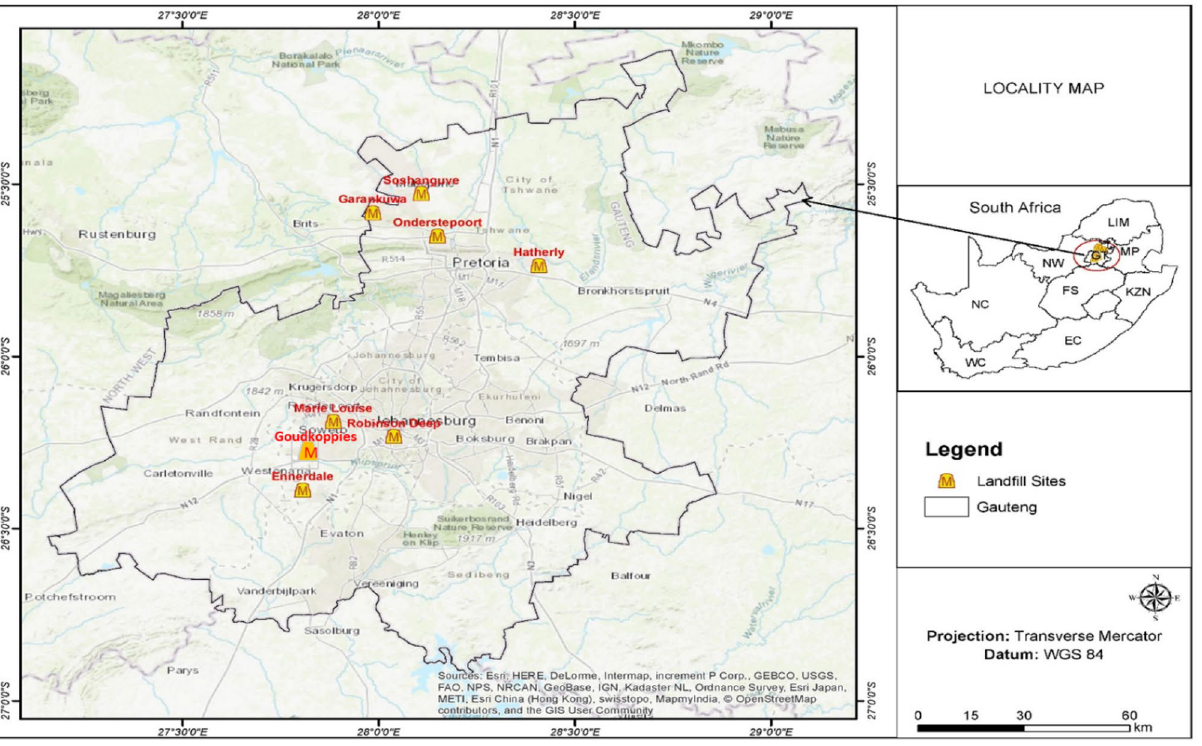
Figure 1. Map of South Africa (top right) and Gauteng Province (centre) showing the selected landfill sites. [The figure was generated by Sogayise 25 in ESRI’s ArcGIS Version 10.1, by using ArcMap with a “World Topographic Map” as a background (http:// www. arcgis. com/ home/ item. html? id= 30e5f e3149 c34df 1ba92 2e6f5 bbf80